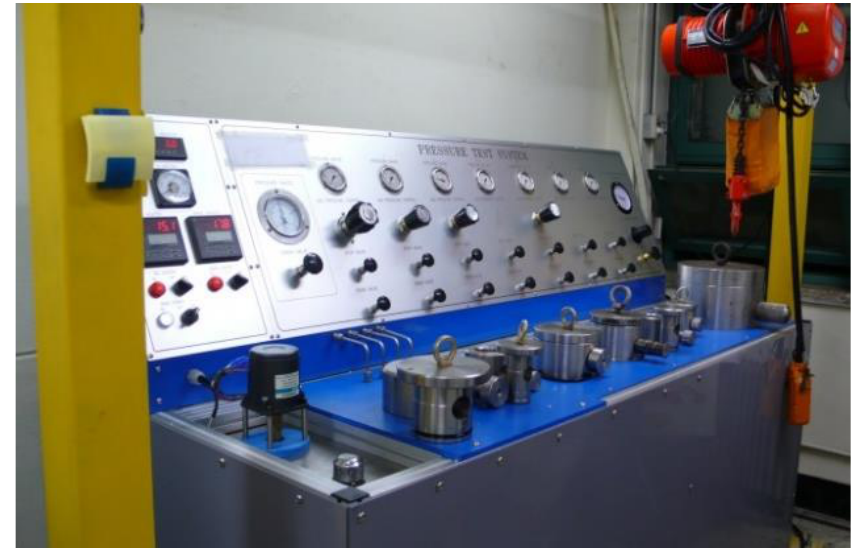
Figure 2. Experiment equipment for the solid-state batch-foaming process.